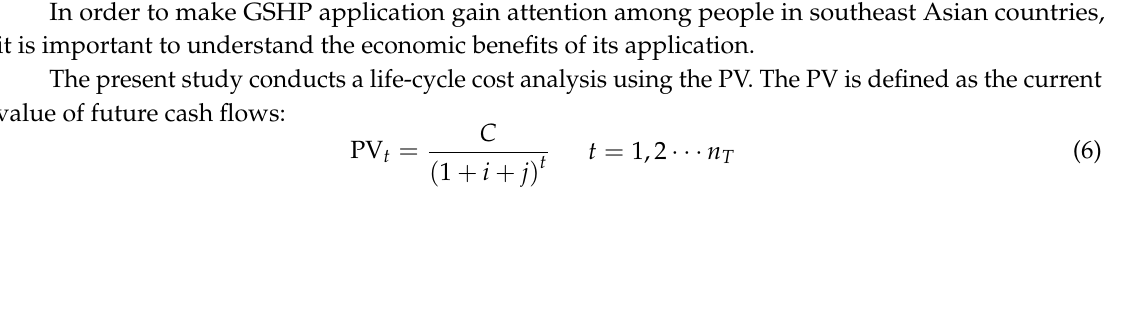
Table 3. Initial and installation costs of each heat pump and heat exchanger.